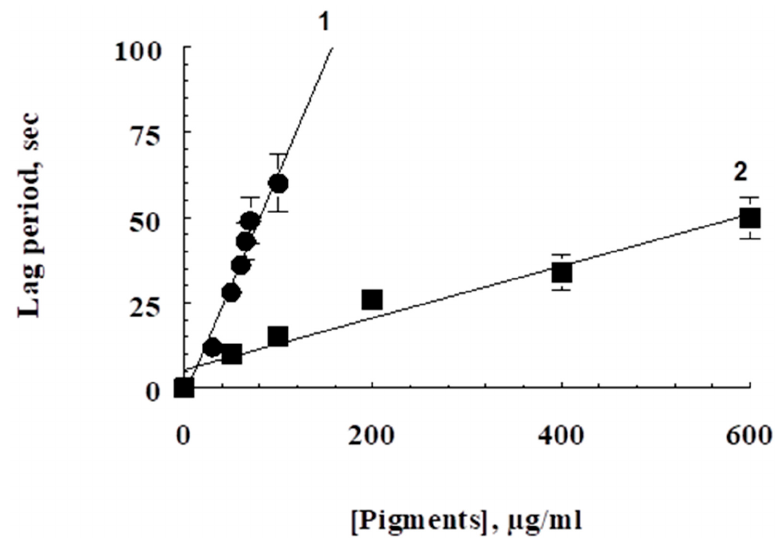
Figure 4. Dependence of the latent period of luminol chemiluminescence on pigment concentration. Curve 1—BSF ommochromes are added; curve 2—BSF water-soluble melanin is added. Data are means (means ± SD) of three assays.